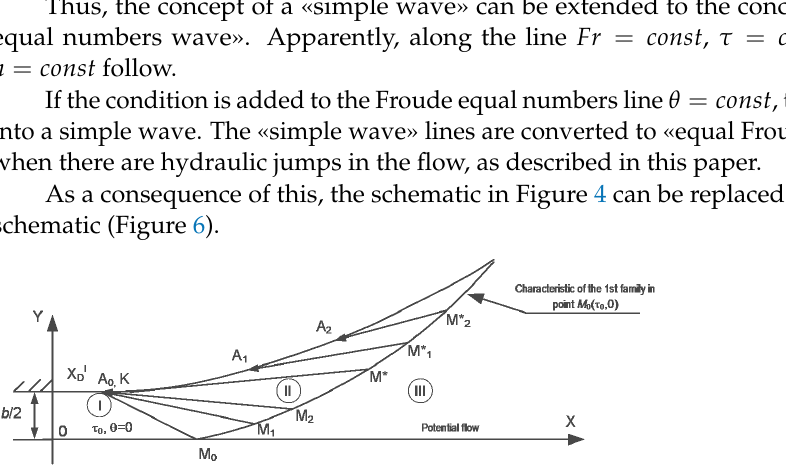
the extreme current line (confirmed by experiments), and the disturbance lines are the lines current line and the first family